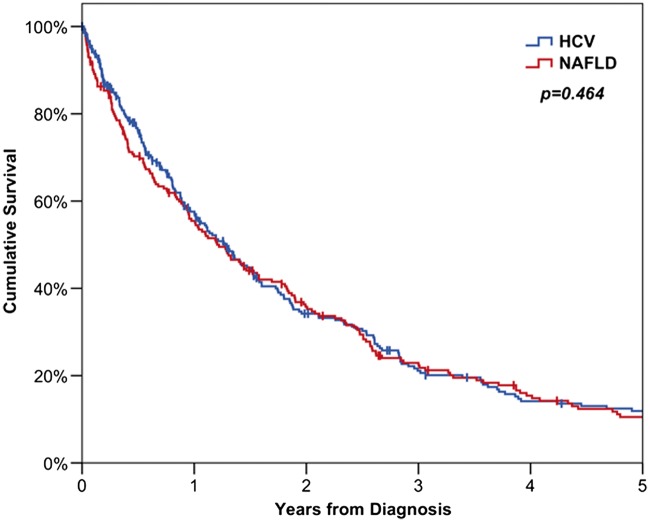
Kaplan-Meier curves for overall survival of patients with HCC. HCV, Hepatitis C viral infection; NAFLD, non-alcoholic fatty liver disease.